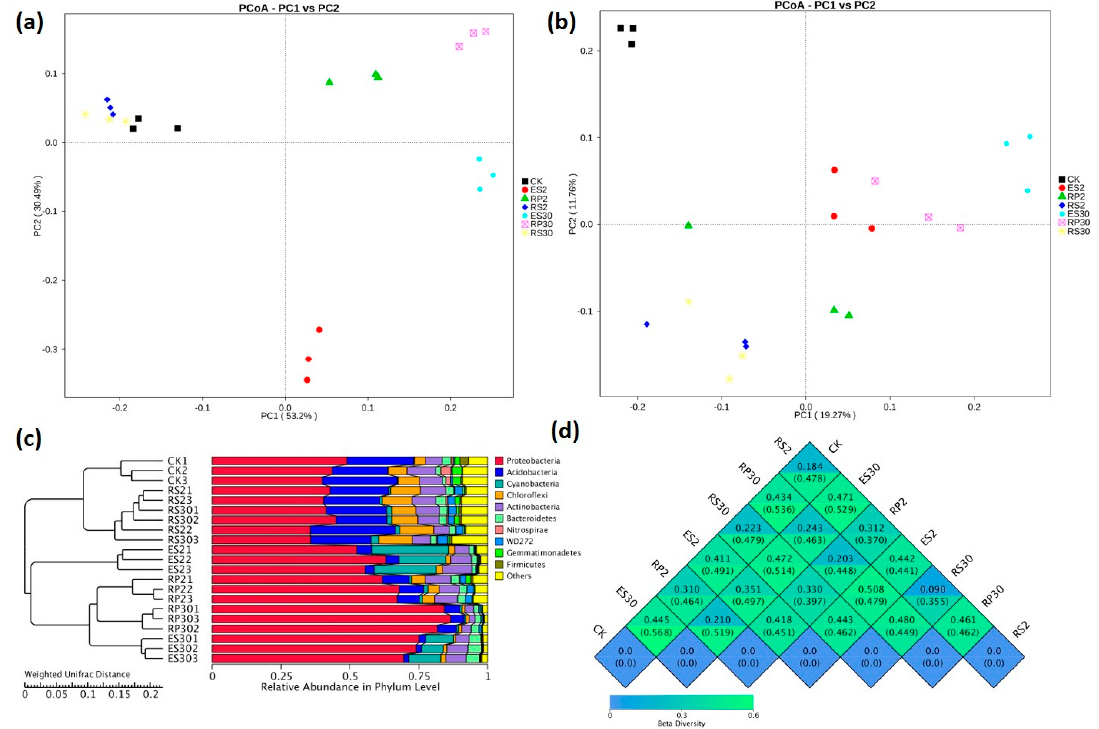
Figure 5. Biplot ordination of ( a ) weighted UniFrac principal coordinate analysis (PCoA) and ( b ) Unweighted UniFrac (UUF) principal coordinate analysis (PCoA) among various samples. CK represents a nearby uncultivated field, while RS2, RP2, and ES2 represent the rhizosphere, rhizoplane, and endosphere of the two-year tea plantation, and RS30, RP30, and ES30 represent the rhizosphere, rhizoplane, and endosphere of the 30-year-old tea plantation. ( c ) UPGMA/hierarchical clustering analysis based on weighted UniFrac distances showing the relative abundance of the most abundant bacterial phylum in various rhizo-compartments of different tea plantations of different ages. ( d ) β -diversity heat map based on weighted (WUF) and unweighted (UUF) UniFrac distances. Values in the upper and lower corners represented the WUF and UUF distances.